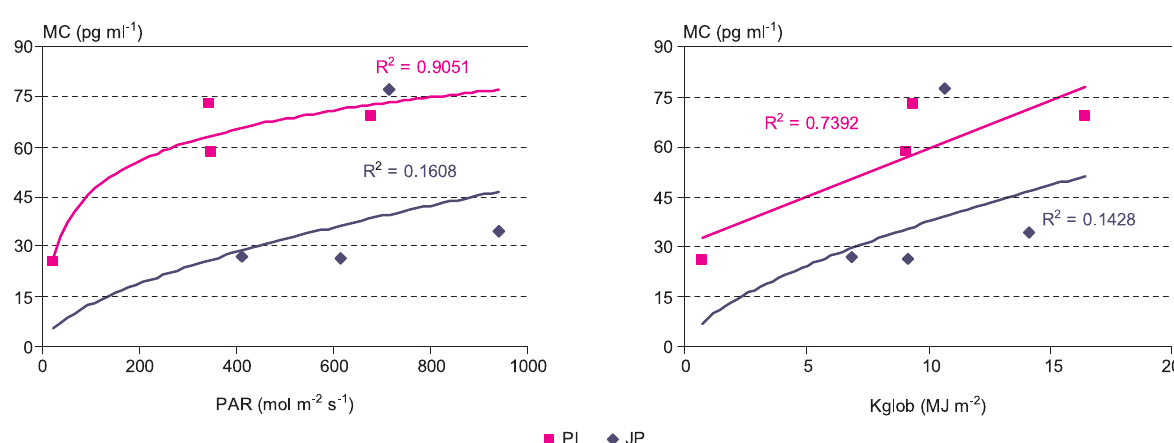
Fig. 5. Statistical relationships between observed day time (from 7 a.m. till 7 p.m.) characteristics of outdoor lighting con- ditions: average intensity of photosynthetically active radiation (PAR) and totals of global solar radiation (Kglob) and the highest night melatonin concentration (MC) at Japanese (JP) and Polish (PL) subjects